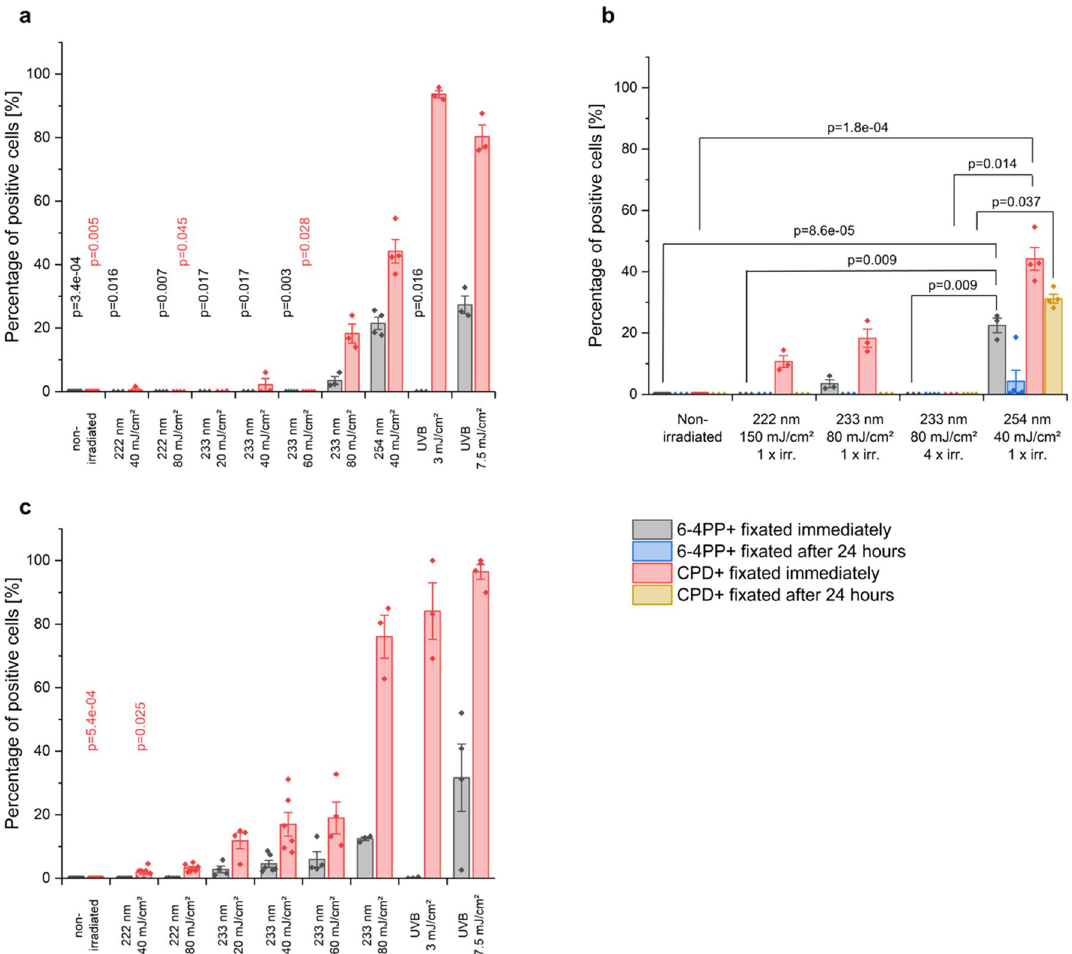
Figure 3. DNA damage of RHEs fixated directly ( a ) and 24 h after UV irradiation ( b ) and excised human skin ( c ). The data show the percentage of positive cells with 6-4PP (grey, blue) and CPD damage (red, orange). For both skin models, non-irradiated skin (negative control) shows no damage. In RHEs 44.2% of epidermal cells irradiated with 40 mJ/cm 2 at 254 nm (positive control) show CPDs and 21.5% of the epidermal cells show 6-4PPs. In excised human skin, irradiation with 3 mJ/cm 2 of UVB (positive control) induced 84.1% CPD positive cells. A reduction in DNA damage of RHEs was observed for fixation 24 h after irradiation with 40 mJ/ cm 2 at 254 nm (positive control), indicating a DNA repair mechanism ( b ). The CPD damage after 150 mJ/ cm 2 irradiation with 222 nm disappeared when fixating 24 h after irradiation. The weak damage after 233 nm irradiation with 80 mJ/cm 2 when fixated immediately, disappeared when fixating 24 h later. Consecutive irradiation at 80 mJ/cm 2 of 233 nm every 24 h did not show any DNA damage. The presented p-values derive from multiple comparisons with Bonferroni corrections after a Kruskal–Wallis test. Every group was compared to the positive control ( a , c ) and additionally the influence of multiple irradiations and fixation time was checked ( b ). The data show mean ± SEM. n = irradiation with 150 mJ/cm 2 at 222 nm, the (10.7 ± 1.9)% CPD damage disappeared when the RHEs were fixated 24 h after irradiation. For 80 mJ/cm 2 irradiation at 233 nm, the immediately determined CPD damage disappeared during 24 h of further incubation. In order to evaluate a possible accumulative effect, the measurements were repeated after multiple irradiations. RHEs were irradiated four times every 24 h with the identical dose and incubated in medium at 37 °C in between. No DNA damage was observed at 80 mJ/cm 2 at 233 nm (Fig. 3b). Non-irradiated control RHEs were incubated for the entire time with daily breaks for 30 min, showing no DNA damage. Selected investigations using cleaved caspase-3 staining for apoptosis 31 showed no apoptosis positive cells of RHEs fixated after 24 h for 40 mJ/cm 2 at 254 nm ( n = 4), 150 mJ/cm 2 at 222 nm ( n = 3), as well as 60 ( n = 4) and 80 mJ/cm 2 ( n = 4) at 233 nm, as well as for non-irradiated RHEs ( n = 3) (data not shown). Additionally to RHE irradiation, experiments were also performed on excised human skin obtained from plastic reduction surgeries. Here, UVB (280–400 nm) at 3 mJ/cm 2 (≈ 1/10 MED) was applied as a positive control leading to (84.1 ± 8.9)% CPD damage, while non-irradiated skin showed no DNA damage ( p = 5.4e−04) (Figs. 3c, 5).